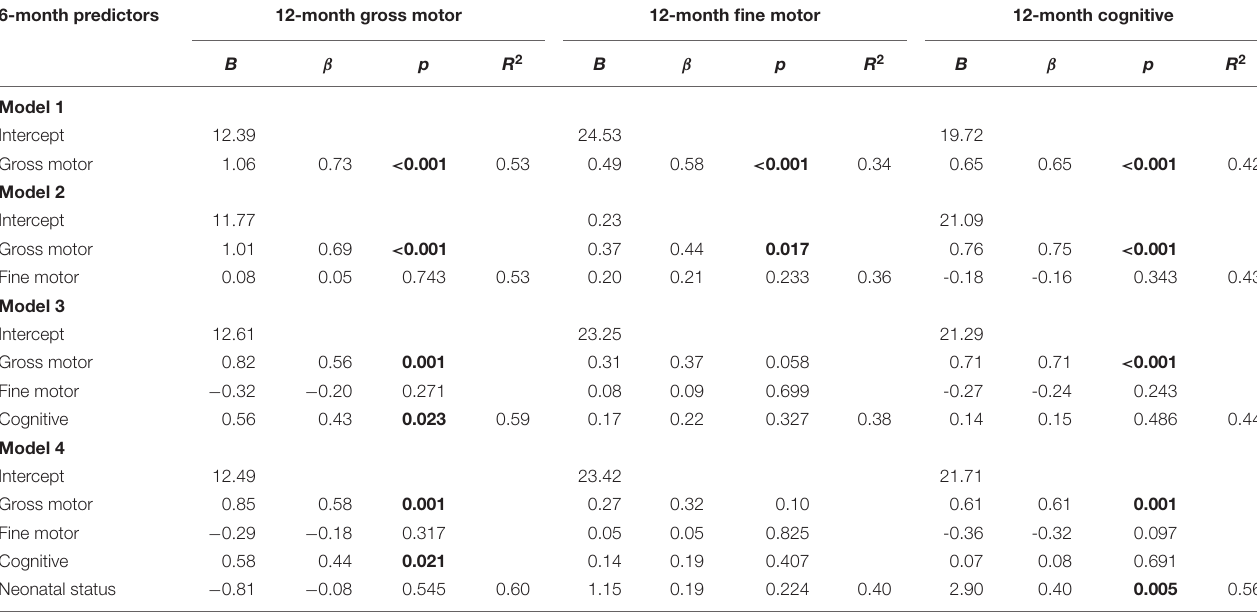
TABLE 4 | Hierarchical regression analyses models for 12-month gross motor, fine motor, and cognitive scores. 6-month